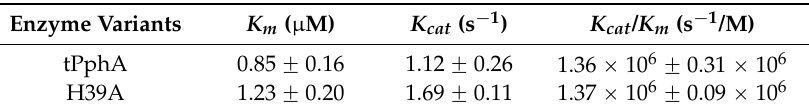
Table 3. Catalytic constants of tPphA and H39A towards